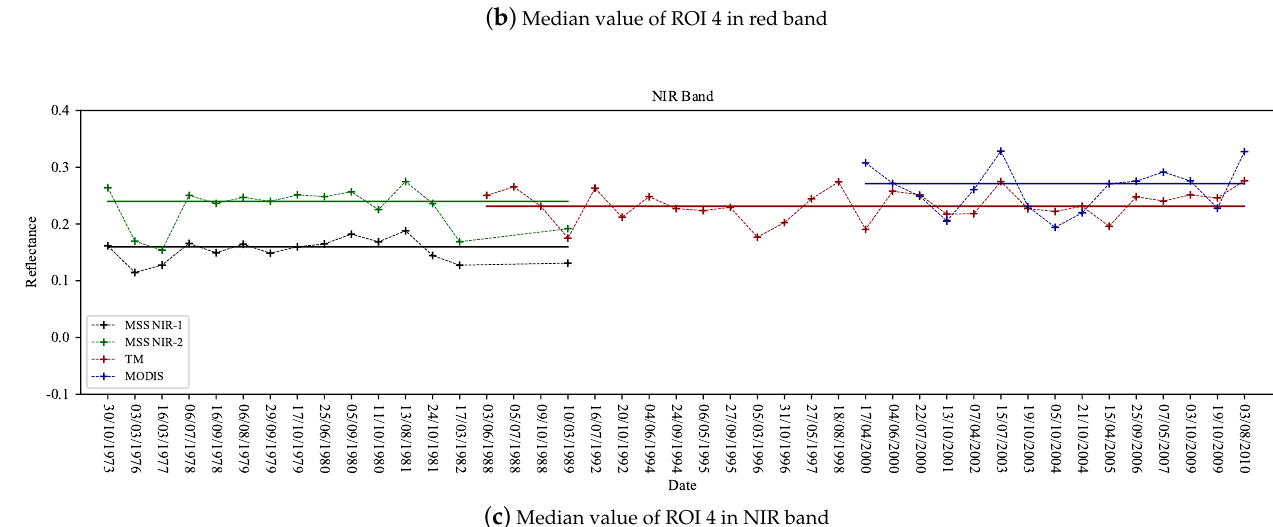
( c ) Median value of ROI 4 in NIR band Figure 15. Time series of ROI 4 median value (ROI 4: